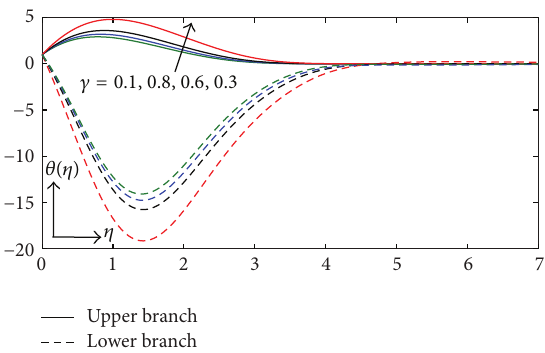
Figure 9: Velocity profiles for various values of 𝜆 with 𝑠 = −3 , 𝛾 = 1 , 𝑀 = 0.2 , and Pr = 3 .